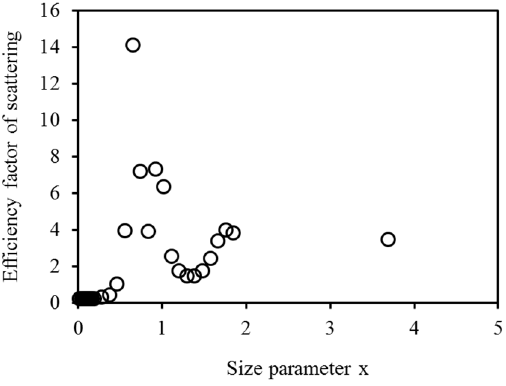
Figure A2. A diagram enlarged along the axis of size parameter x focusing on the range from 0 to 5.